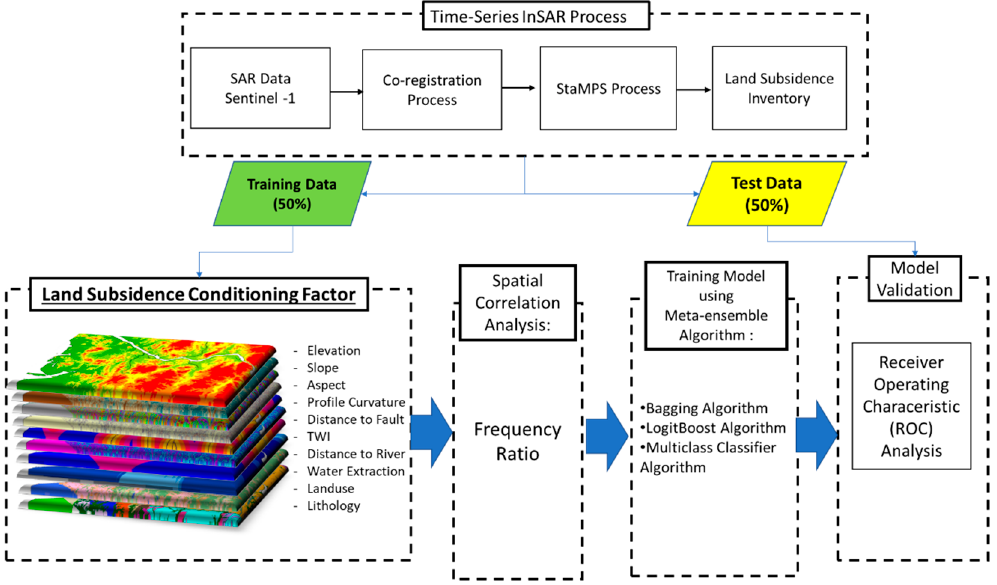
Figure 2. The workflow illustration.